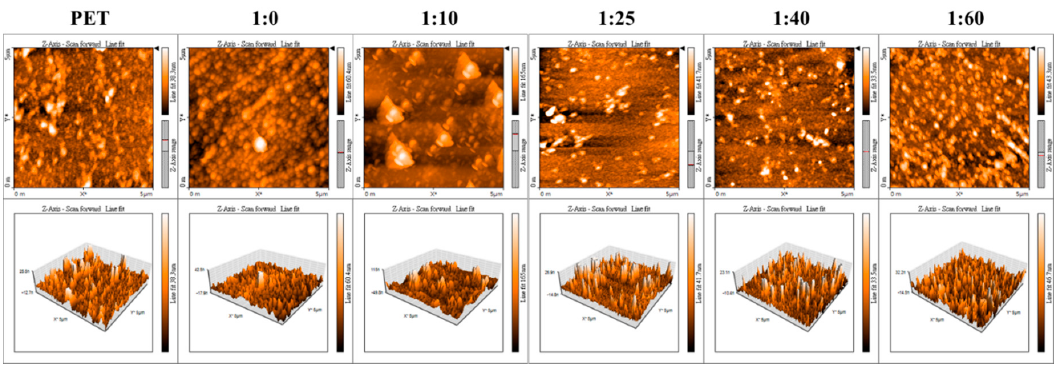
Figure 2. Three-dimensional (3D) atomic force microscopy (AFM) image of the various PDA/SBMA coatings on the PET substrate.